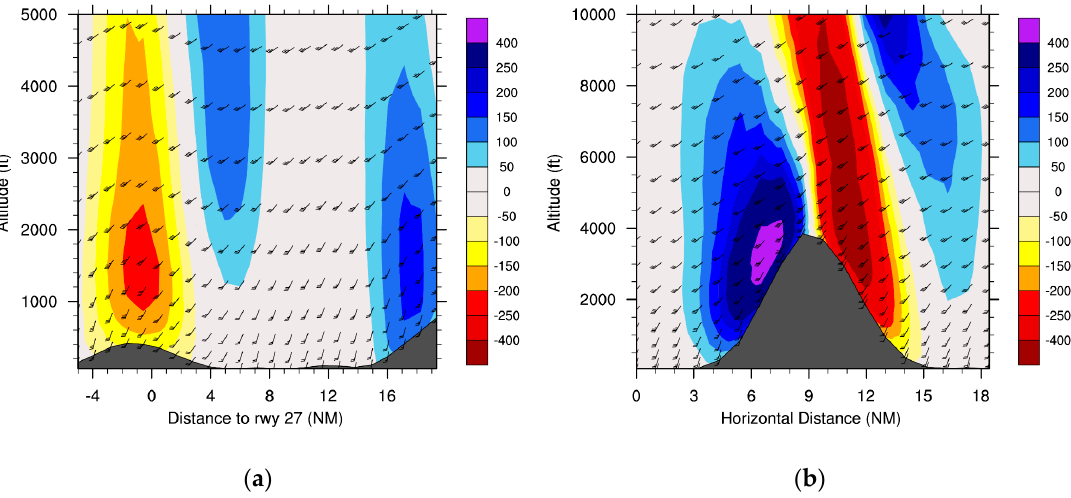
Figure 10. Vertical cross-section of the vertical velocity of AROME through ( a ) line A–B on Figure 2 and ( b ) line C–D on Figure 2, for Flight 1. Shading represents intensity in ft / min, positive values indicate upward vertical velocity and negative values represent downward vertical velocity. The altitude scale of (a) is half of the corresponding scale of ( b ).